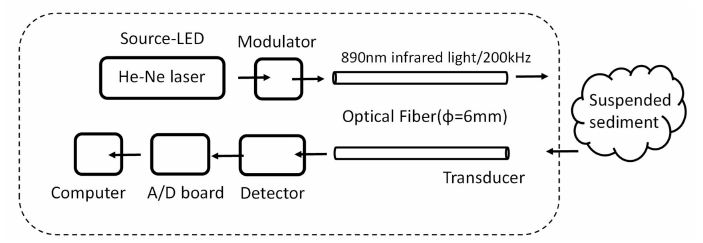
Figure 1. Schematic diagram of the